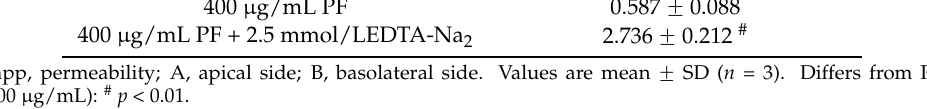
Table 3. The effect of EDTA-Na 2 on transport of PF in MDCK-MDR1 cell monolayer.